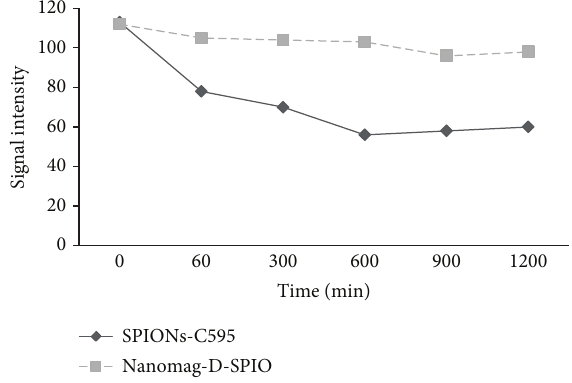
Figure 9: MR image signal intensity of tissues from some region of interest (ROI) at different time after injection of two studied agents.